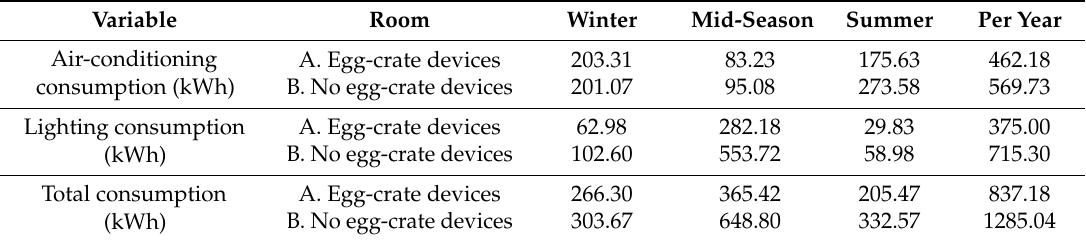
Figure 8. Comparison of annual average electric consumption of air conditioning and lighting systems in both classrooms. Table 10. Comparison of annual average electric consumption of air conditioning, lighting and total in both classrooms.